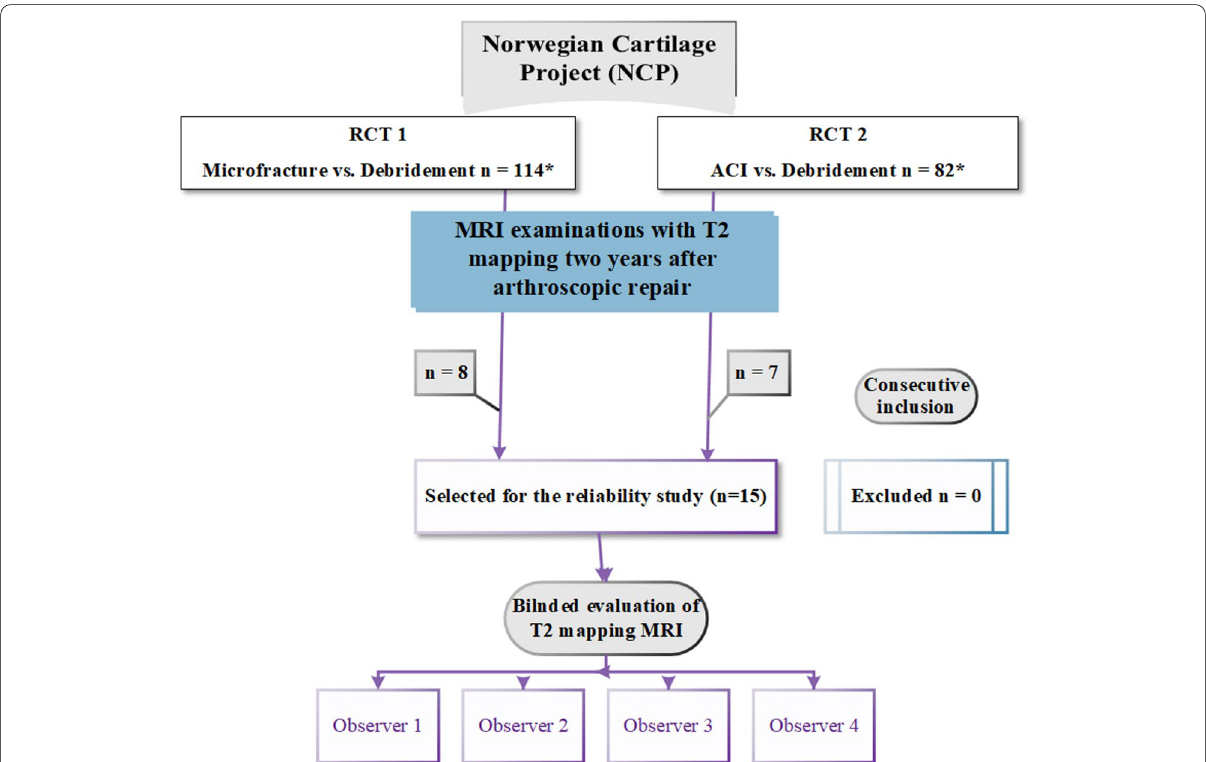
Fig. 1 Flow diagram for the inclusion of the patients in the current reliability study from the two ongoing Randomised Controlled Trials of the Norwegian Cartilage Project. ACI: Autologous Chondrocyte Implantation. * Ongoing